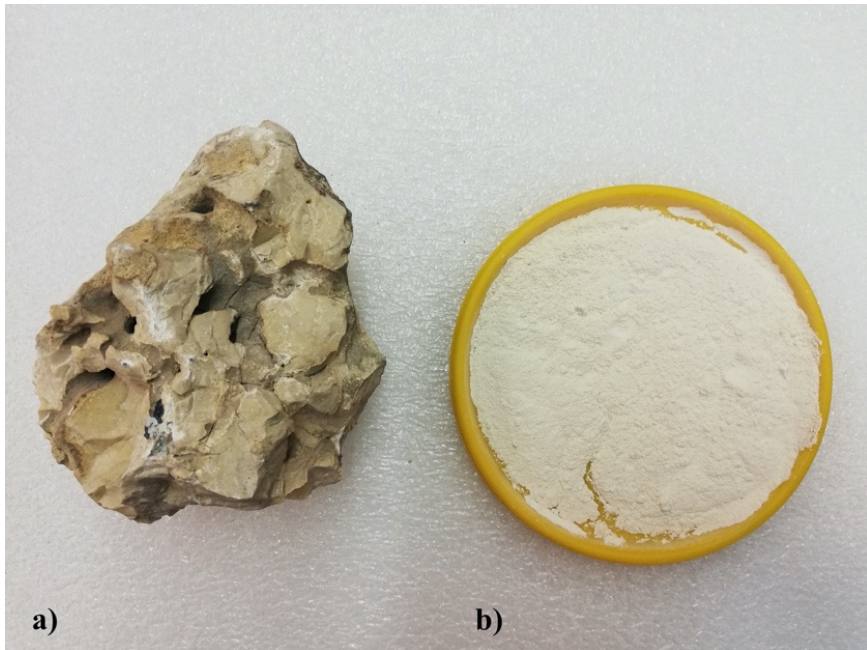
Figure 2. The tufo used to build the Sassi ( a ) and the sample reduced to powder and homogenized ( b